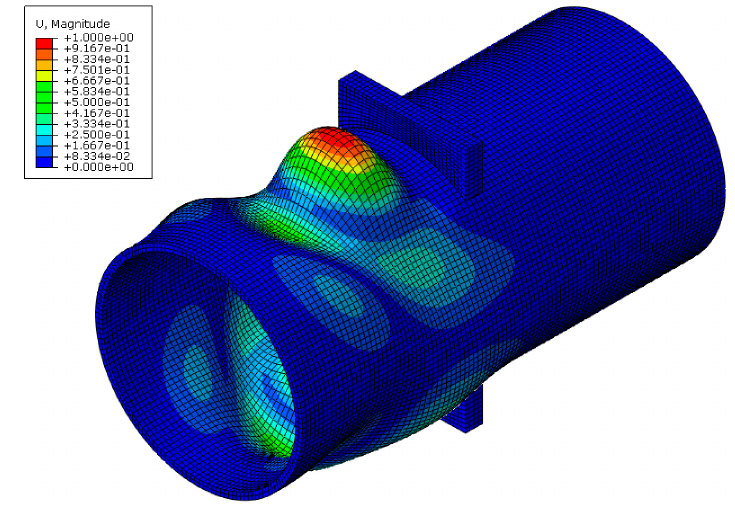
Figure 6. Considered buckling mode.